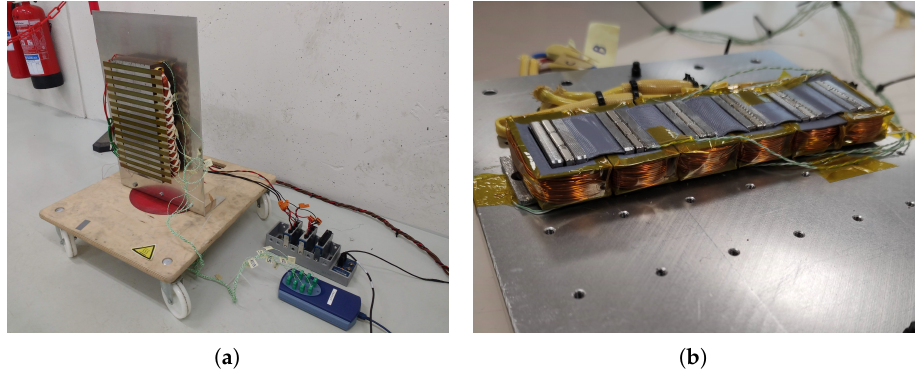
Figure 8. Photos of the thermal test prototypes. ( a ) Linear induction machine. ( b ) Linear switched- flux machine.